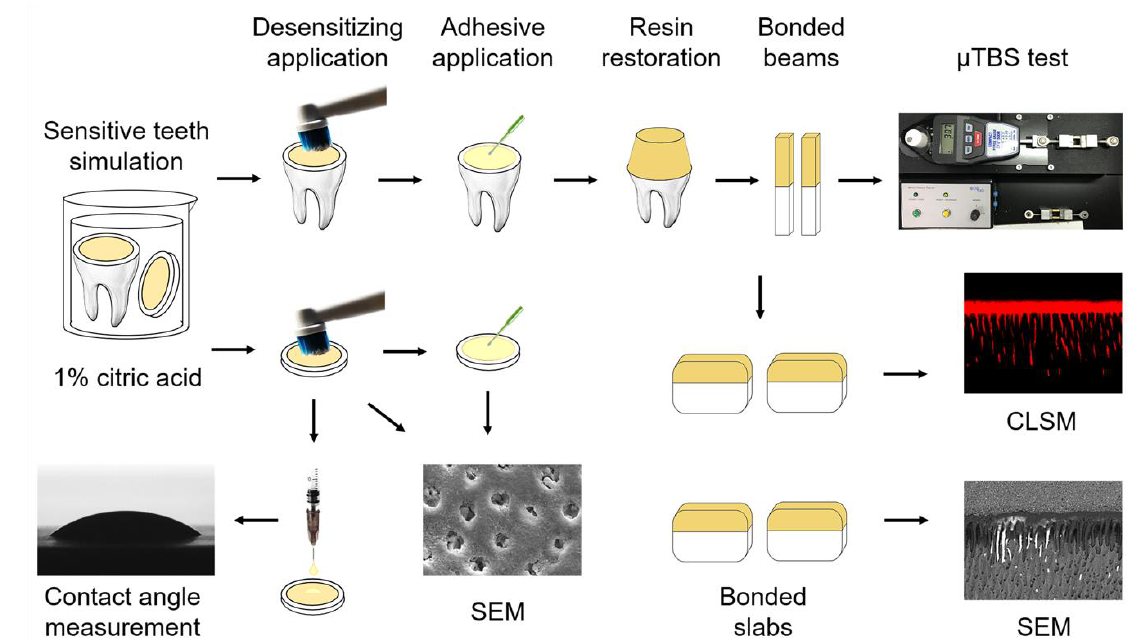
Figure 1. Schematic illustration of the study design. Mid-coronal and disc specimens were prepared for sensitive models and applied by desensitizing treatments. Mid-coronal specimens were bonded with universal adhesives, restored by resin composite, then sectioned into beams and slabs. µ TBS were tested on bonded beams. Adhesive interfaces were observed on bonded slabs by CLSM and SEM. Dentin tubular occlusion before and after adhesive application were analyzed by SEM. Wettability of universal adhesives was measured by the contact angle.